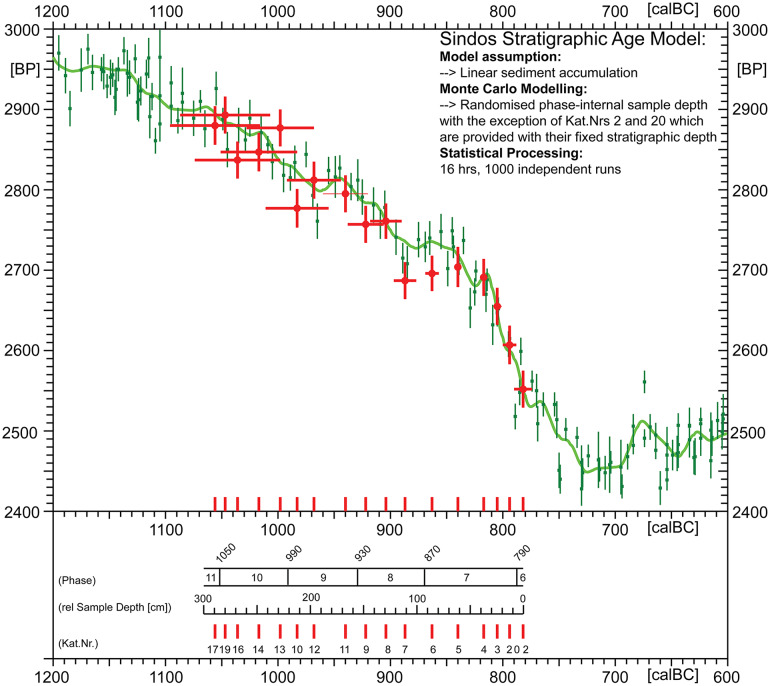
Chronological results for Sindos (phase 11–6) achieved by application of Gaussian Monte Carlo Wiggle Matching (GMCWM) to N = 17 stratigraphically screened 14C-ages.